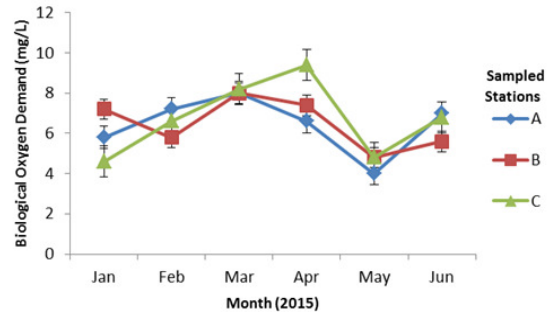
Fig. 9. The monthly mean variation in the biological oxygen demand (mg/L) of the water sampled from Saba River